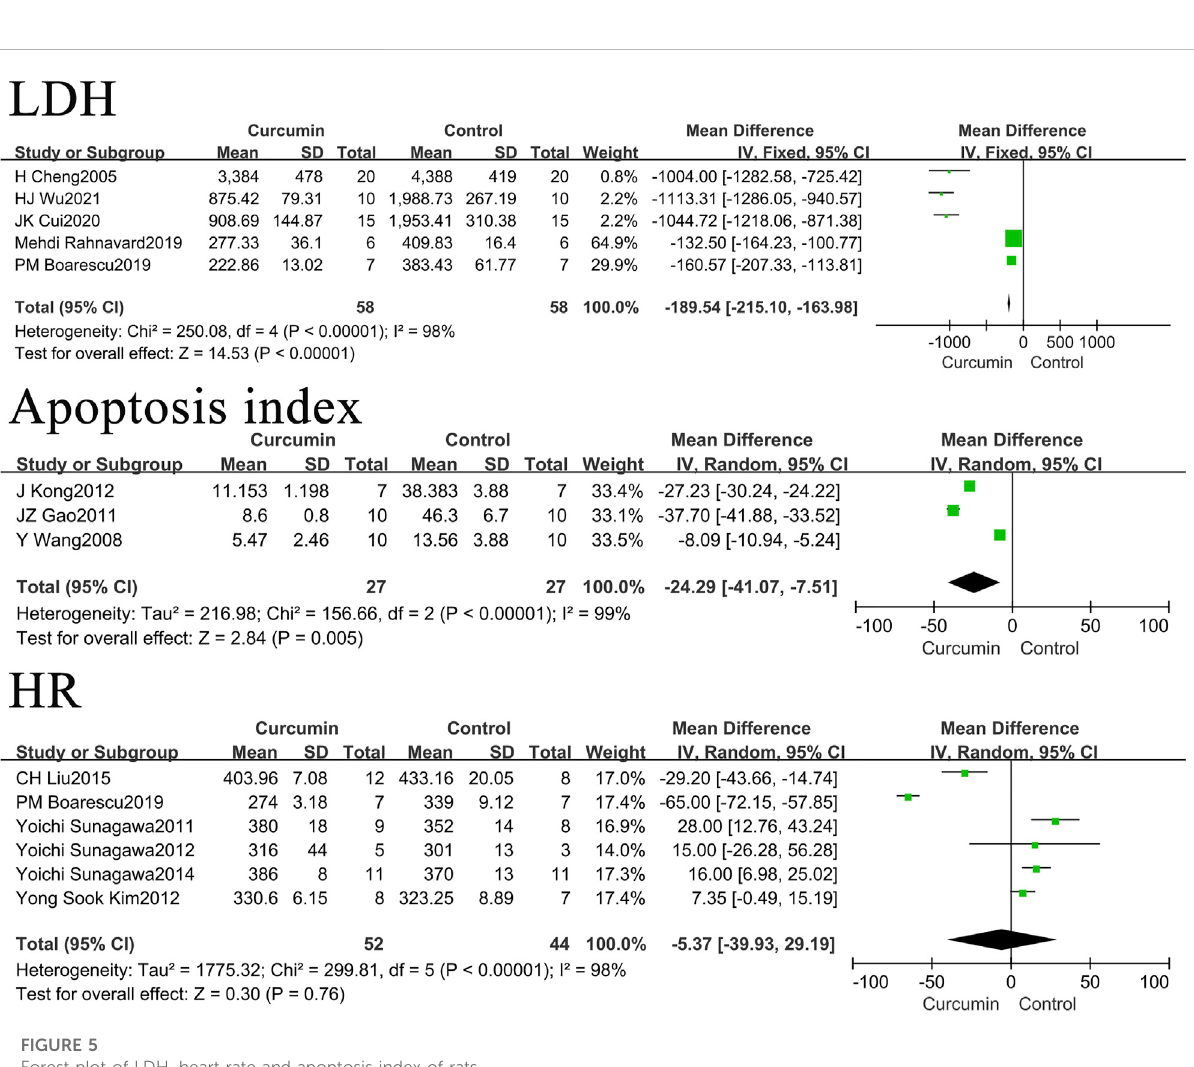
Forest plot of LDH, heart rate and apoptosis index of